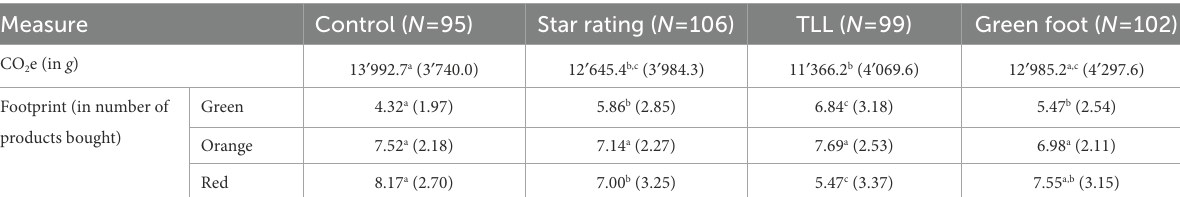
TABLE 1 Outcome measures for the shopping task per condition.